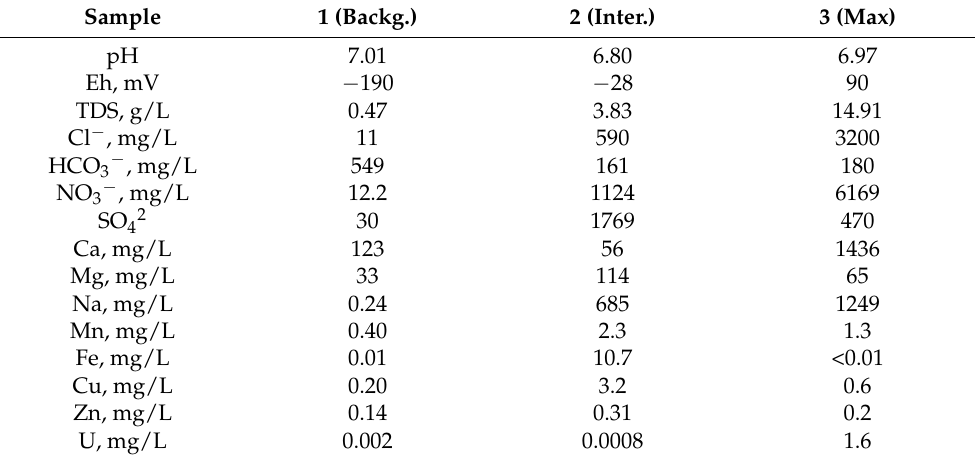
Table 1. Chemical composition, total dissolved solids (TDS), and Eh–pH of the study